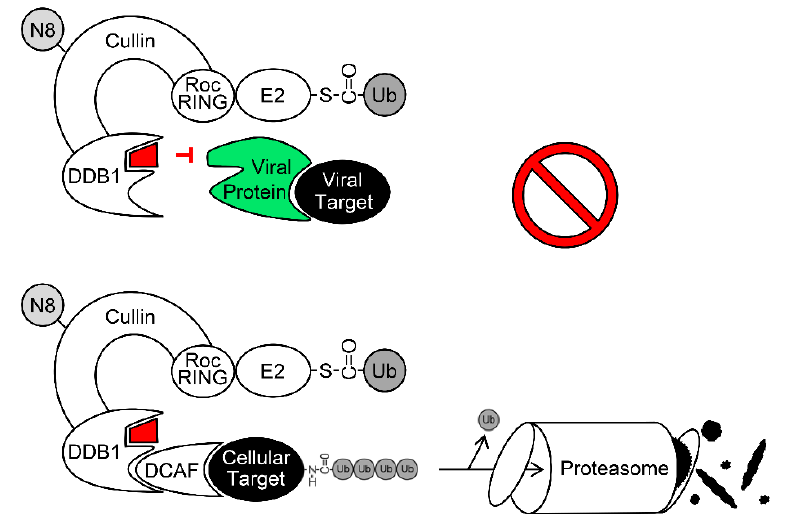
Figure 2. A strategy to target viral exploitation of CRLs without interfering with their cellular function. Please read the text for details.